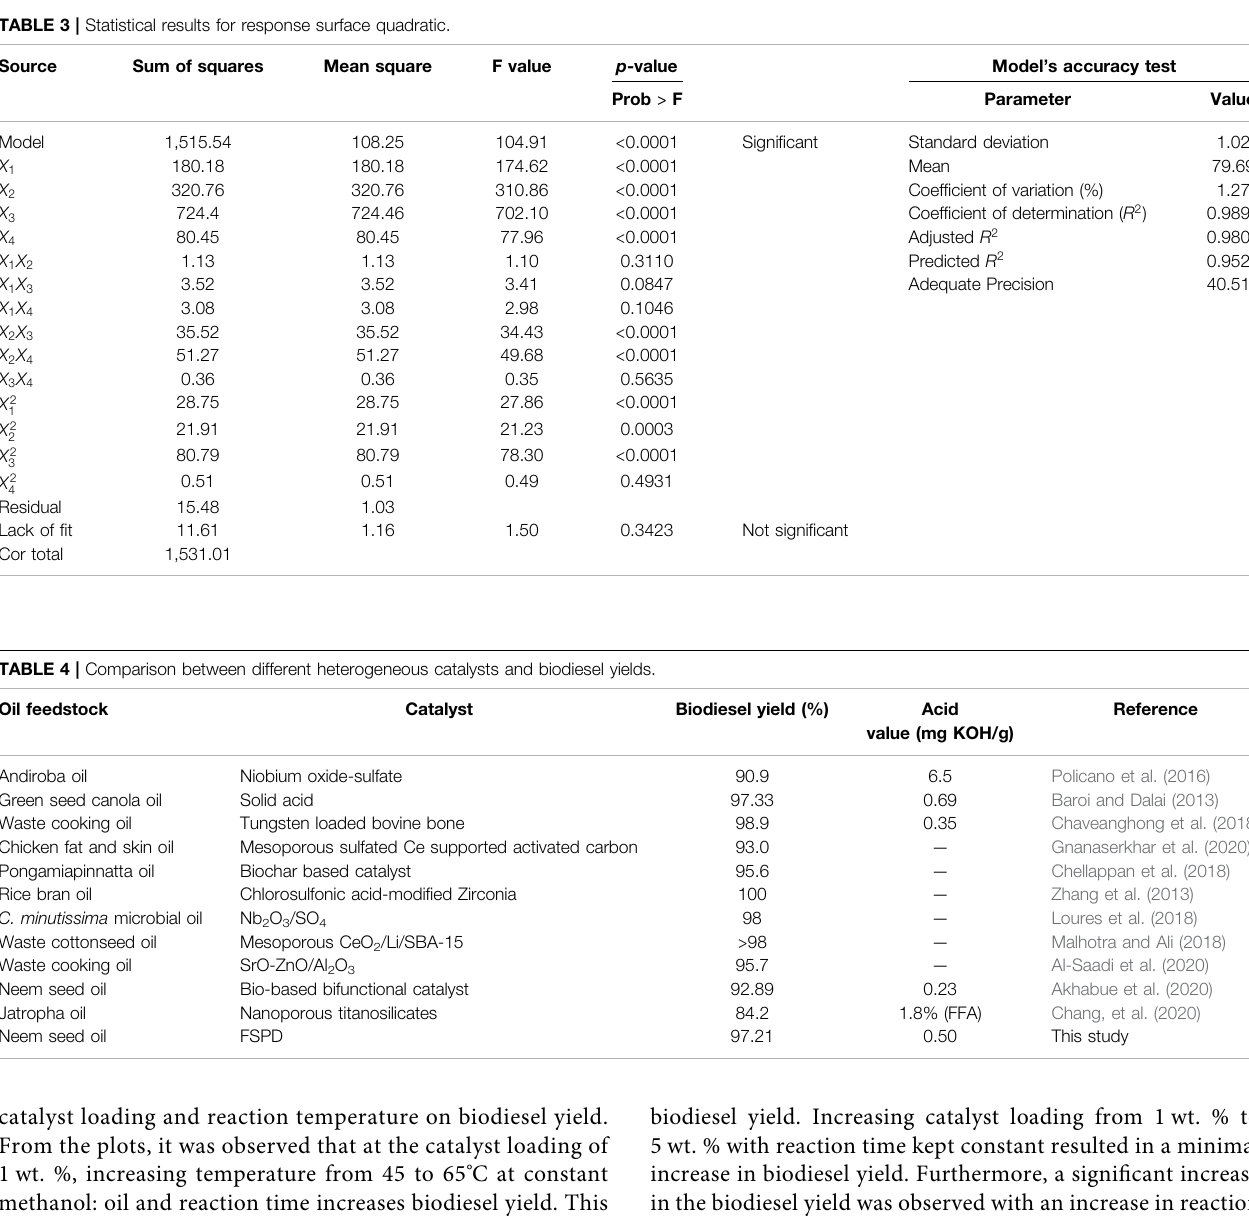
TABLE 3 | Statistical results for response surface quadratic. Source Sum of squares